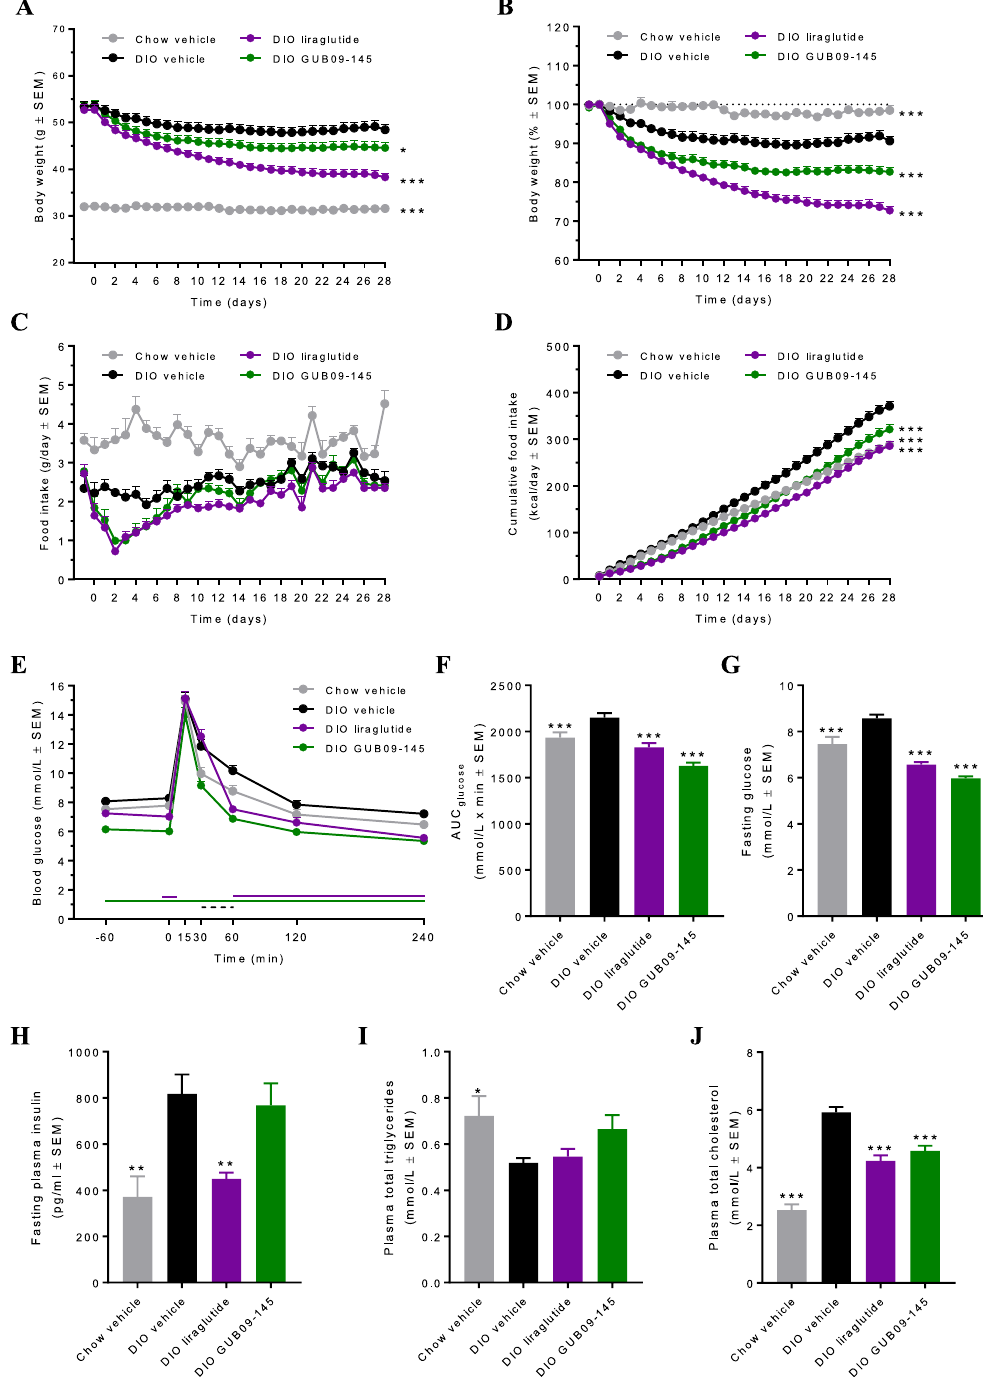
Figure 1. Liraglutide and GUB09-145 improve metabolic parameters in DIO mice. ( A ) Absolute body weight (g), ( B ) Body weight gain (%) relative to treatment start; ( C ) Daily food intake (g); ( D ) Cumulative energy intake (kcal/day); ( E ) Oral glucose tolerance test (OGTT) on treatment day 27, ( F ) Glucose area-under the-curve (glucose AUC 0-240 min ); ( G ) Fasting blood glucose concentrations (mmol/L) on treatment day 14; ( H ) Fasting plasma insulin levels (pg/ml) on treatment day 28; ( I ) Plasma total triglycerides (TG, mmol/L) on treatment day 28; ( J ) Plasma total cholesterol (TC, mmol/L) on treatment day 28. * p < 0.05, ** p < 0.01, *** p < 0.001 compared to DIO vehicle